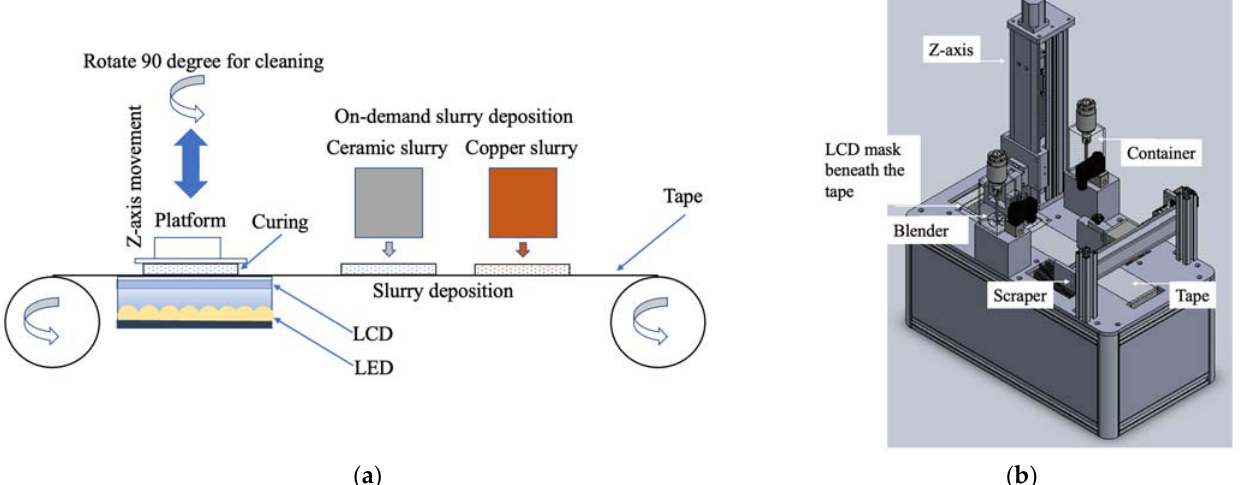
Figure 1. The proposed tape ‐ casting multi ‐ slurry 3D printing process: ( a ) the principle and ( b ) the proposed 3D printer.